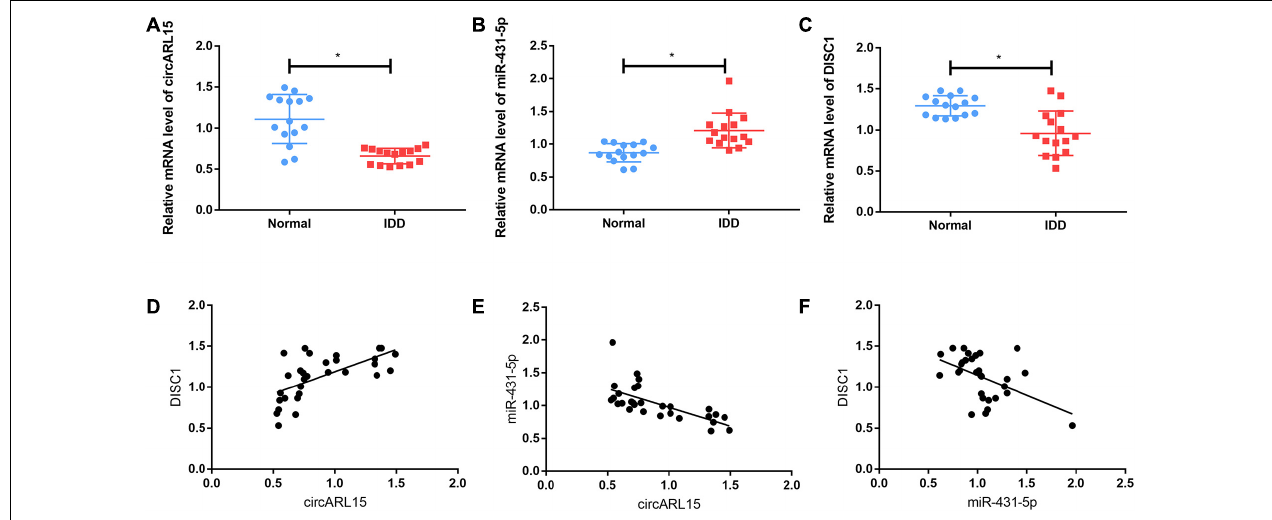
FIGURE 3 | Expression of circARL15, miR-431-5p, and DISC1 in IDD. (A–C) The expressions of circARL15 (A) , miR-431-5p (B) , and DISC1 (C) in IDD and the normal samples. (D–F) circARL15 was positively correlated with DISC1 (D) and negatively correlated with miR-431-5p (E) , while miR-431-5p was negatively correlated with DISC1 (F) * p <